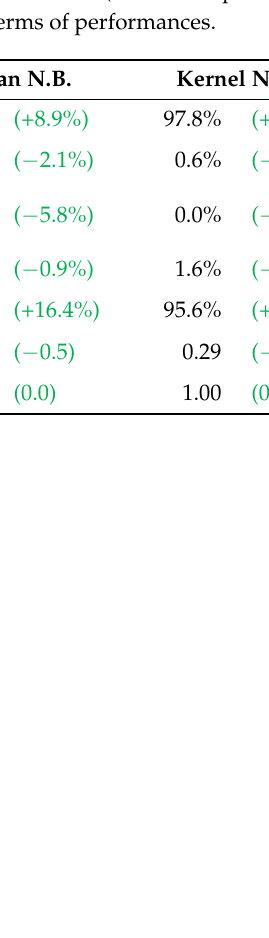
Figure 9. Representation of the first 3 Mahalanobis distances (i.e., calculated with respect to groups 0, 2 and 3).